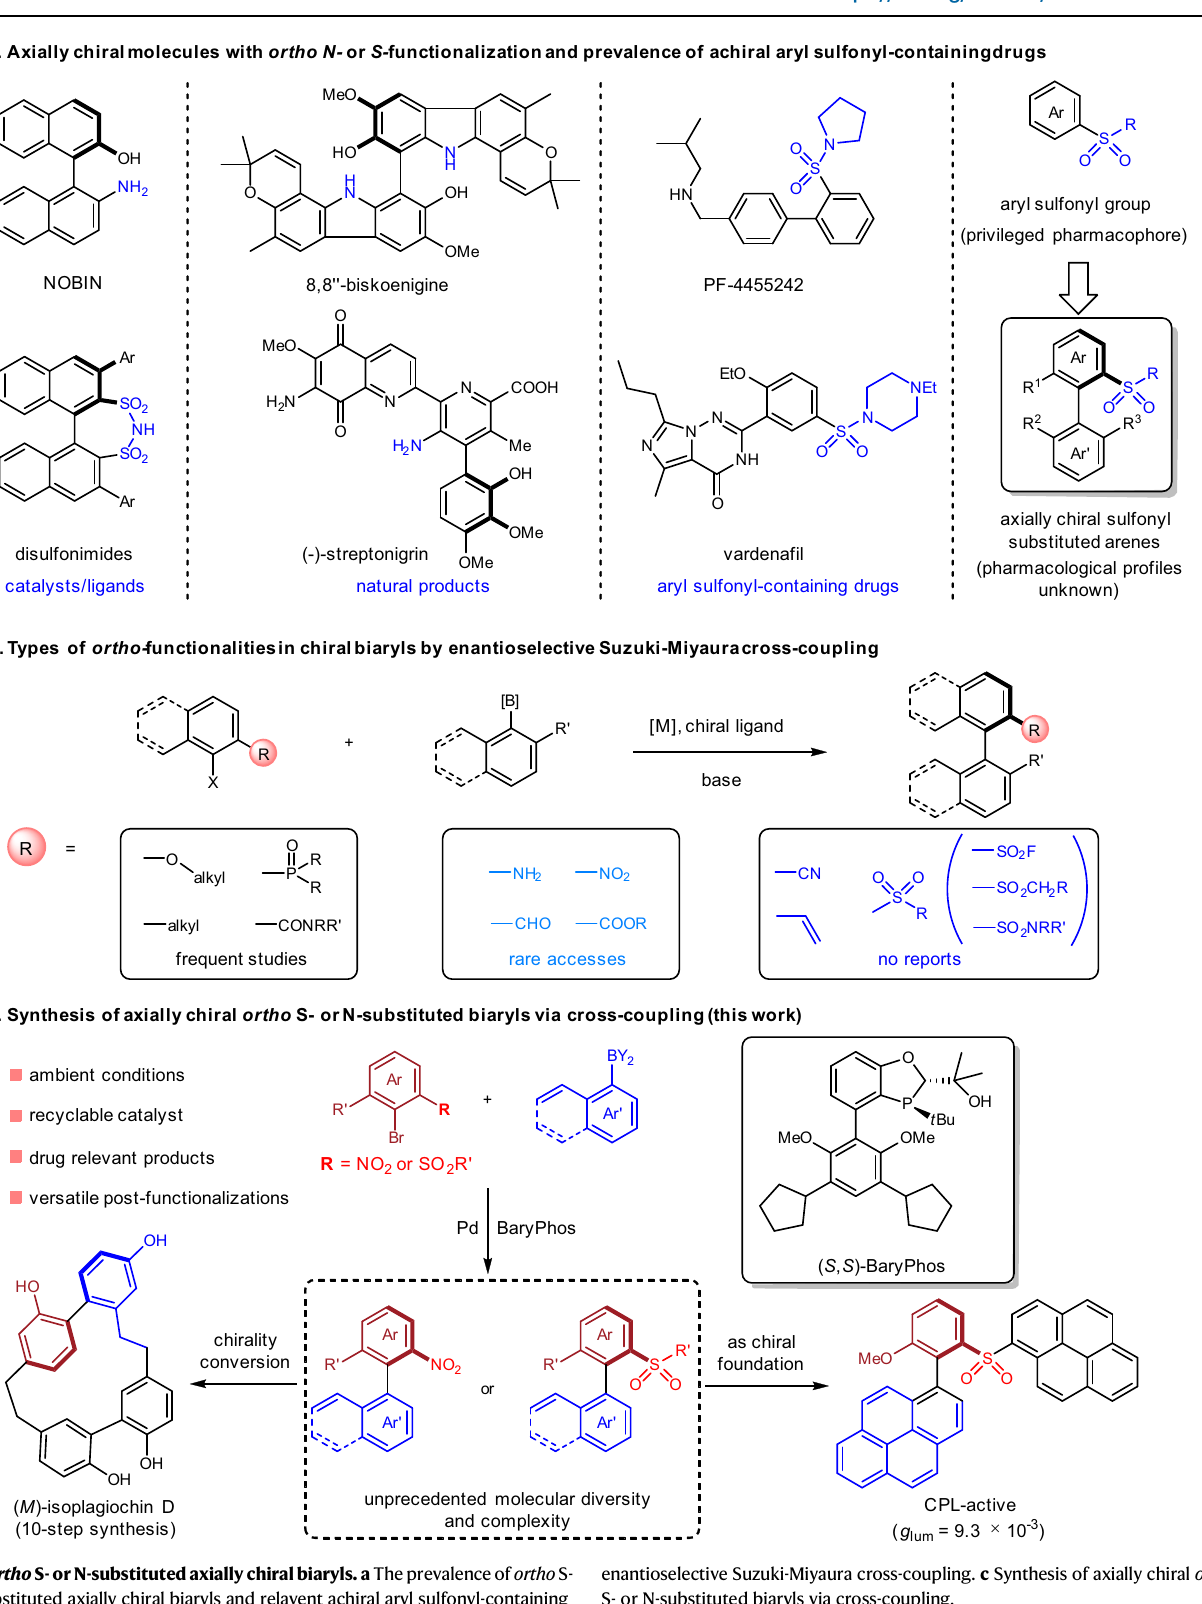
enantioselective Suzuki-Miyaura cross-coupling. c Synthesis of axially chiral ortho S- or N-substituted biaryls via